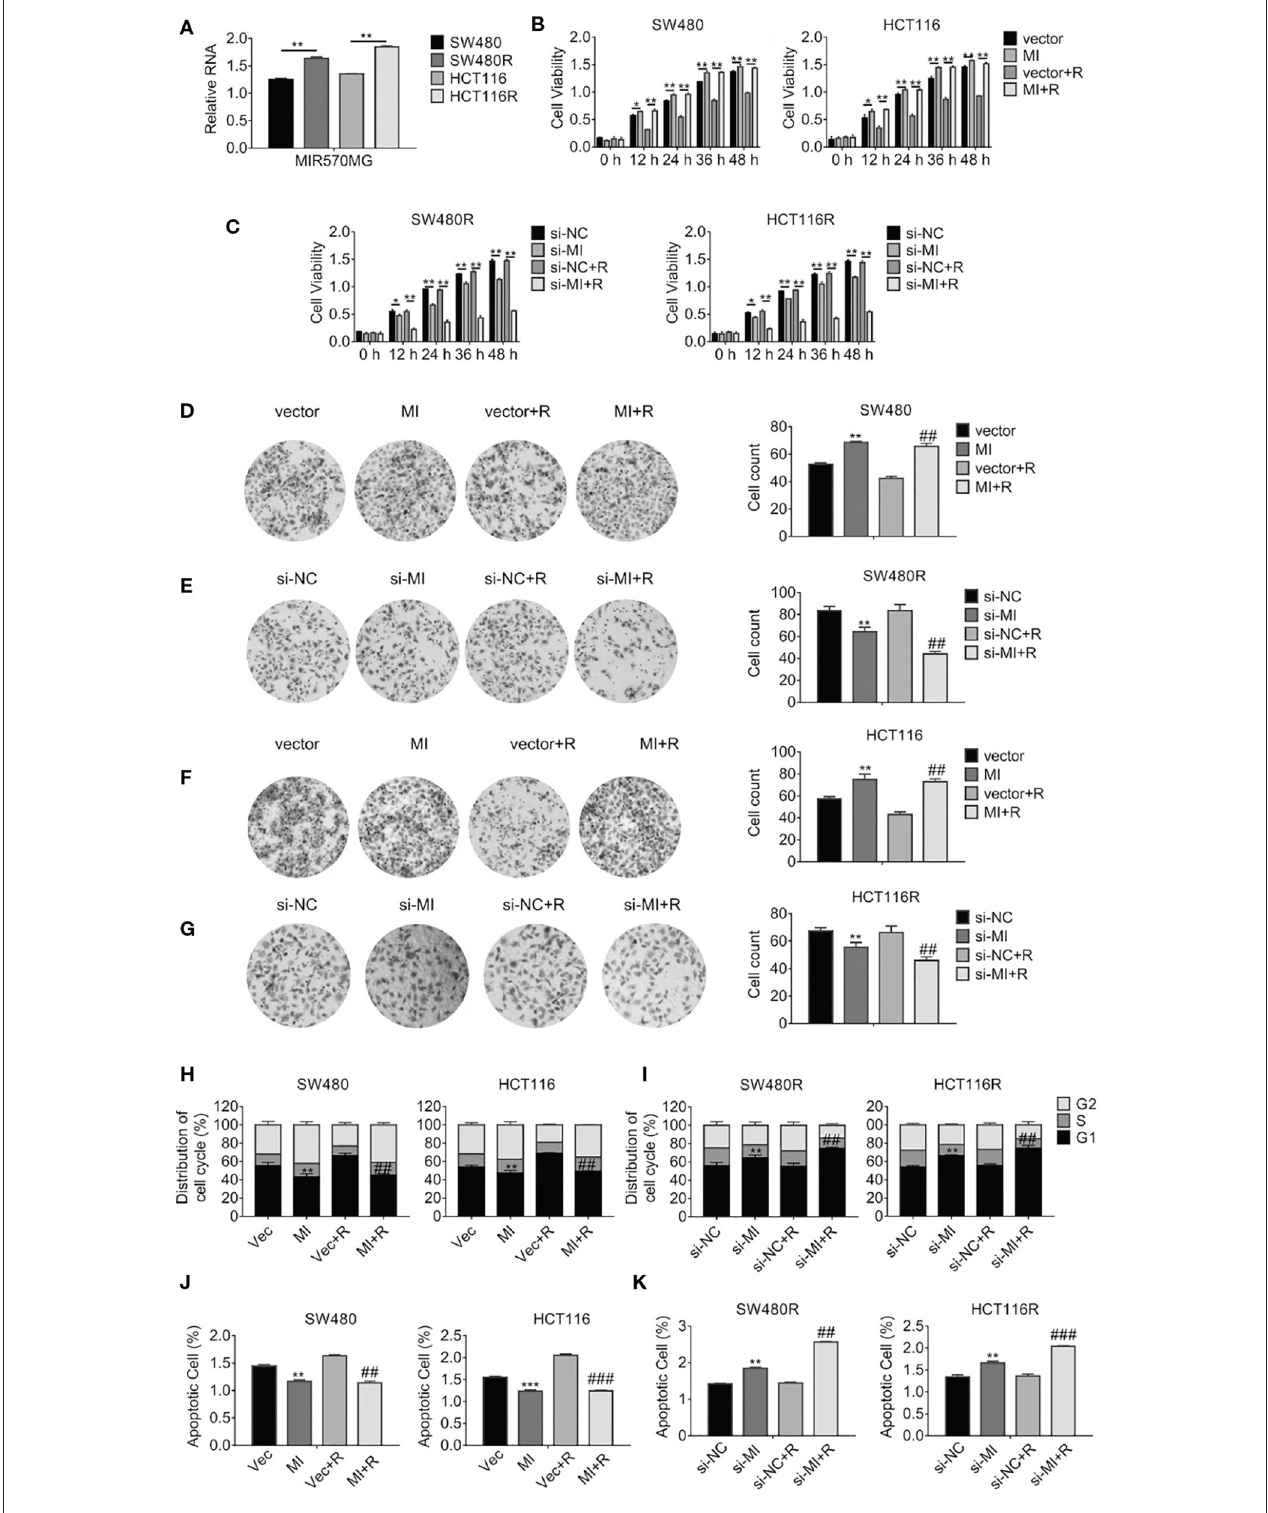
FIGURE 2 | LncRNA MIR570MG expression increases and enhances the cell viability of regorafenib-resistant cell lines. (A) Expression of MIR570MG in regorafenib resistant- and parental cells. (B) The viability of the indicated cells was accessed by the MTT assay. Cells expressing MIR570MG or vector were exposed to regorafenib. MTT assay was performed at the indicated time-points. (C) The viability of the indicated cells was accessed by the MTT assay. Cells expressing